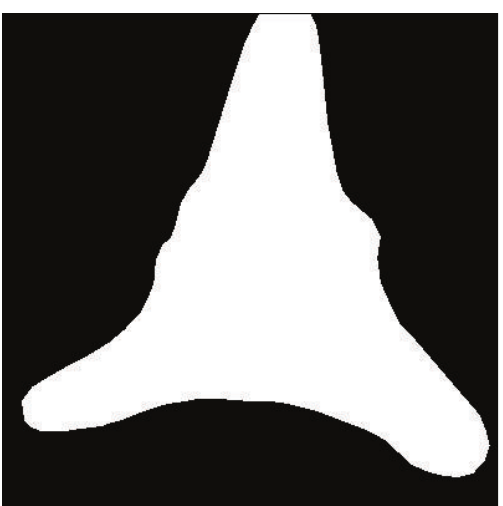
Figure 6: Image of neonatal cardiac myocyte observed by using phase contrast microscope and captured by employing a high-def- inition digital camera.